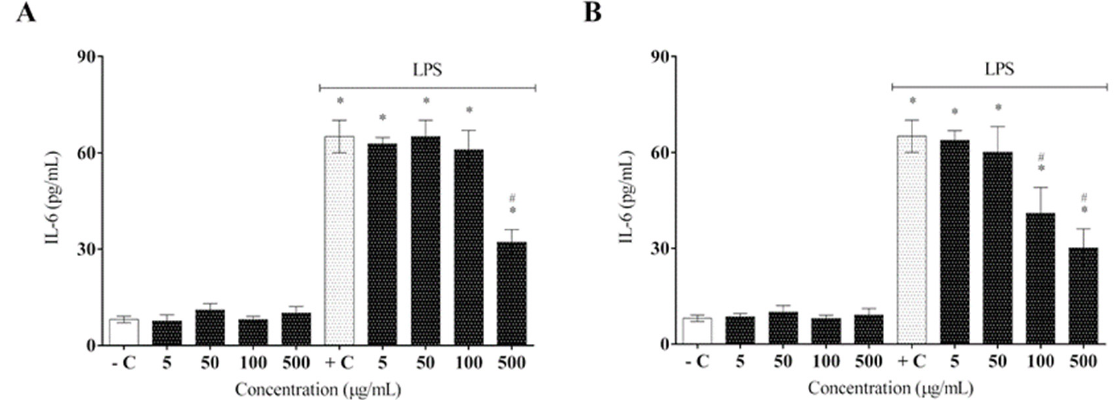
Figure 6. Effect of L. rigida extracts on IL-6 cytokine release: ( A ) AELR and ( B ) HELR. The cytokine content was released in RAW 264.7 cells and stimulated by LPS after 24 h. Release of cytokines was quantified by ELISA analysis. Data represent the mean ± SEM from three independent experiments. One-way ANOVA was used followed by a post hoc Tukey test. * p < 0.05 vs. the negative control group; # p < 0.05 vs. the LPS-stimulated cells.